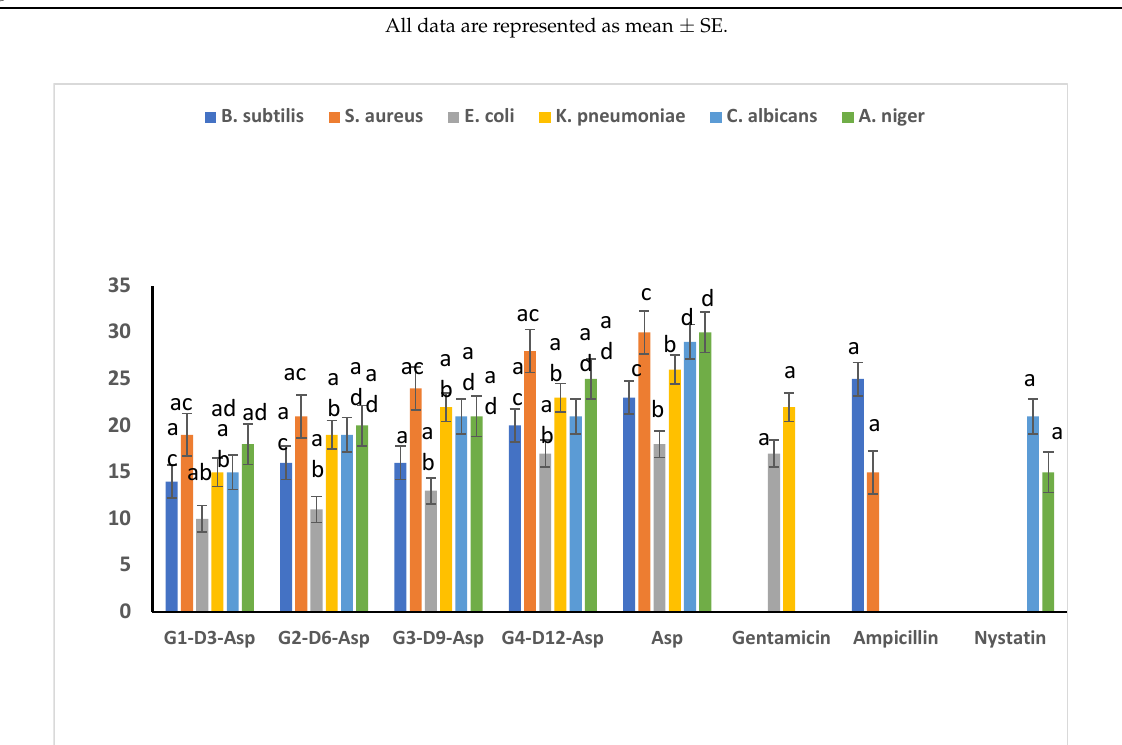
Figure 6. The results of antimicrobial activity for the aspirin and the G1 , G2 , G3 and G4 dendrimers at 15 mg/mL against different strains of bacteria and fungi compared to references. All data are represented as mean ± SE. Statistical significance was measured at p < 0.05 based on one-way analysis of variance ANOVA test followed by Tukey ’ s test for multiple comparisons. a was significantly different from the aspirin group at p < 0.05, b was significantly different from the gentamicin group at p < 0.05, c was significantly different from the ampicillin group at p < 0.05, and d was significantly different from the nystatin group at p < 0.05.